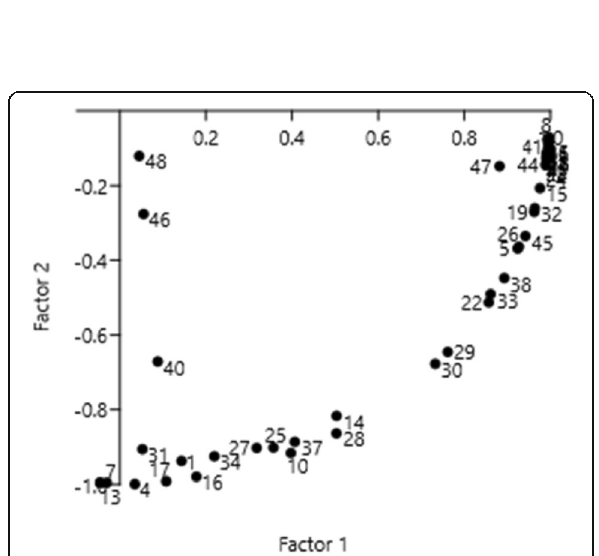
Fig. 7 Varimax scatter plot of organic acid contents of raw food items and milk under in E. coli cultures for 0 h, 24 h, and 72 h treatments using CABFAC factor analysis. (Environmental variable=time of